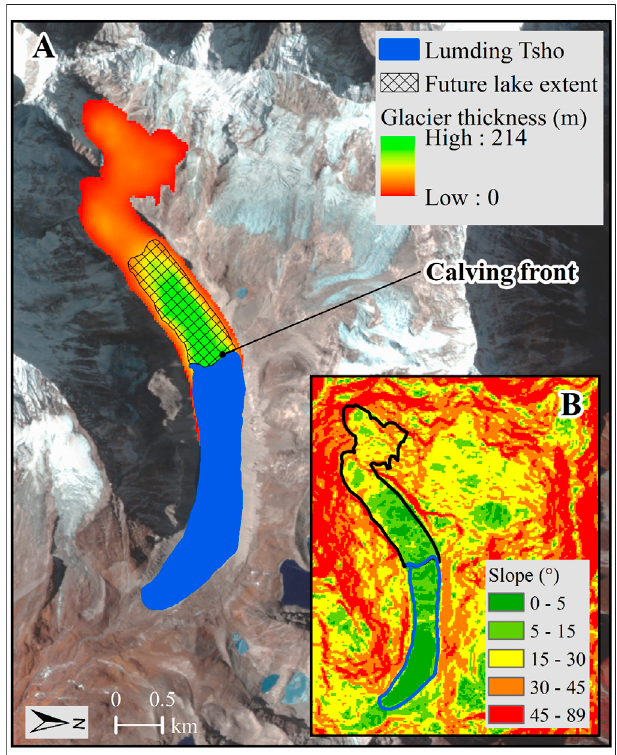
FIGURE8|(A) PossiblefutureexpansionofLumdingTshoderivedfrom the slope (B) and modeled glacier ice thickness of its parent glacier (Farinotti et al.,